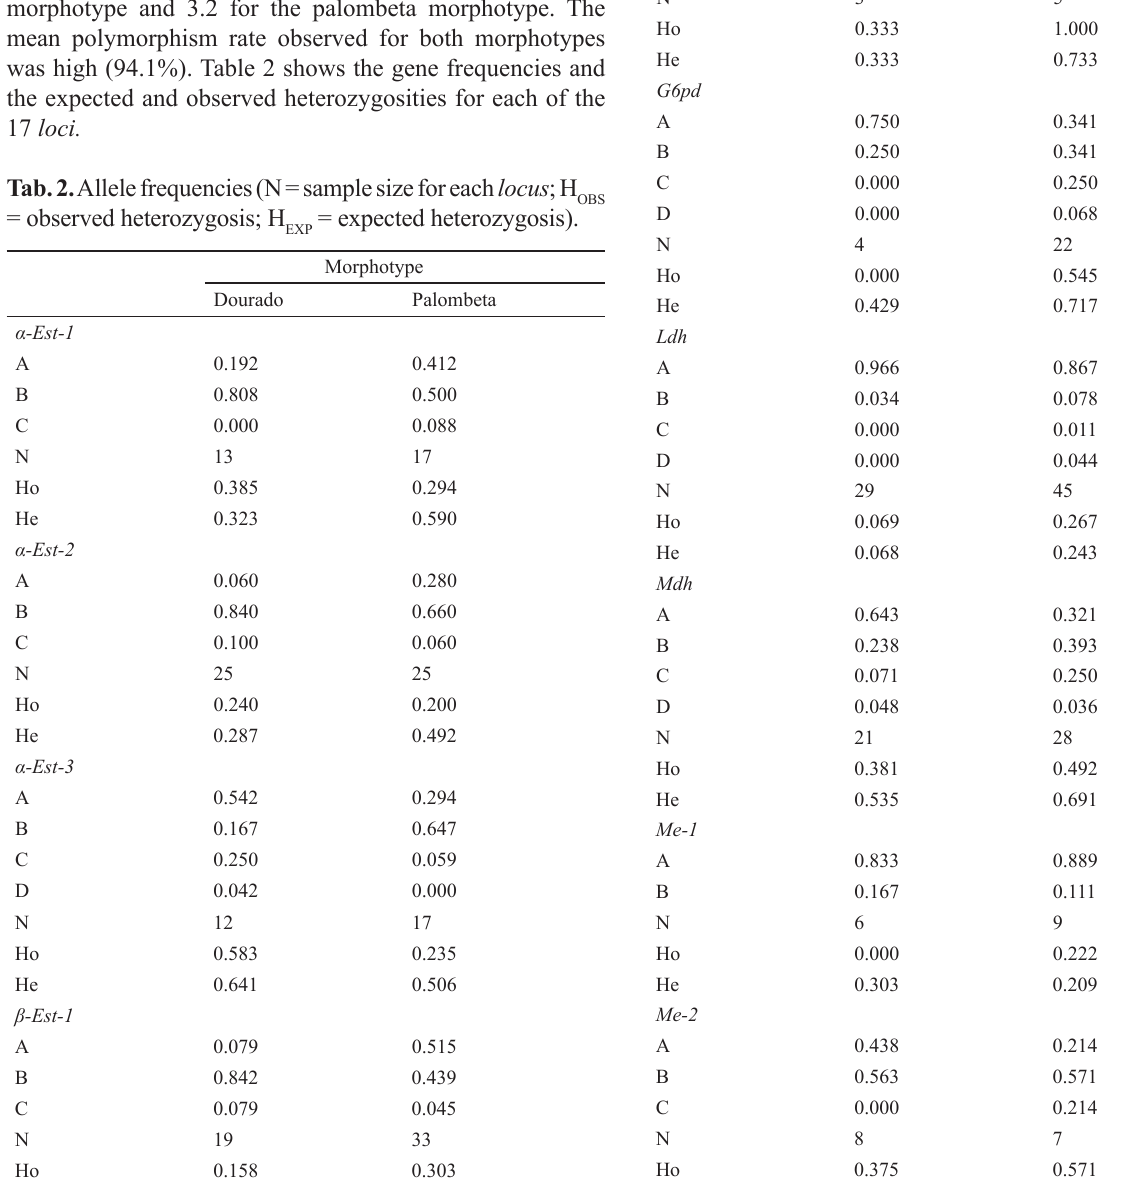
Tab. 2. Allele frequencies (N = sample size for each locus ; H = observed heterozygosis; H